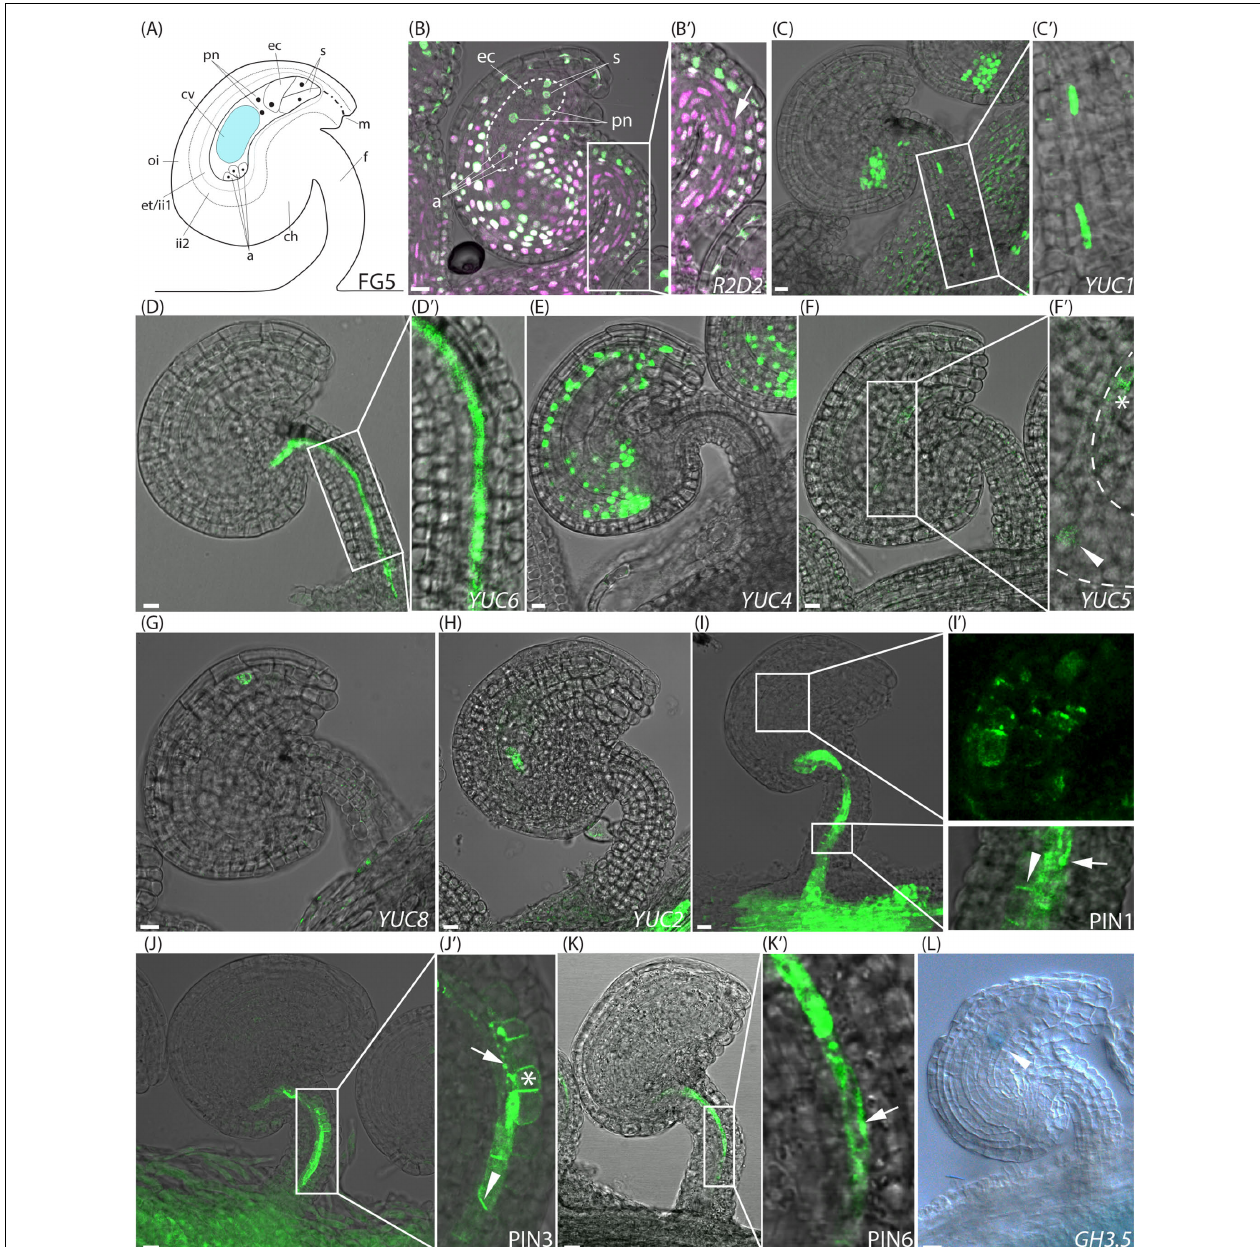
FIGURE 1 | Activity of auxin related reporters at the pre-anthesis stage of FG5. (A) Schematic overview of an ovule at stage FG5. a, antipodal cells; ch, chalazal domain; cv, central vacuole; ec, egg cell; et, endothelium; f, funiculus; ii, inner integuments; m, micropylar end; oi, outer integuments; pn, polar nuclei; s, synergid cells. (B–K) Merged confocal and transmitted light images, showing the expression of different fluorescent reporter constructs in ovules carrying an embryo sac at the seven cell, eight nuclei stage. (B (cid:48) ,C (cid:48) ,D (cid:48) ,F (cid:48) ,I (cid:48) ,J (cid:48) ,K (cid:48) ) show higher magnifications of the boxed areas in (B,C,D,F,I,J,K) , respectively. (B,B (cid:48) ) R2D2 activity, dotted area indicates the female gametophyte with annotations as in (A) , arrow indicates DII depletion in the central funicular cell files. (C) YUC1pro:n3xGFP expression in the chalazal domain of the ovule and in the third cell file of the funiculus, (D) YUC6pro:eGFP expression in the fifth cell file of the funiculus, (E) YUC4pro:3xGFP expression in the inner integuments, (F,F (cid:48) ) YUC5pro:eGFP expression in the micropylar end of the inner integuments (star) and in the female gametophyte (arrowhead), dashed line indicates female gametophyte, (G) YUC8pro:eGFP expression in the micropylar end of the inner integuments, (H) YUC2pro:eGFP expression in the female gametophyte, (I,I (cid:48) ) PIN1pro:PIN1-GFP expression around the female gametophyte and in the three most central cell files of the funiculus, arrowhead indicates basal PIN1 localization, arrow indicates internal PIN1 localization. (J,J (cid:48) ) PIN3pro:PIN3-GFP expression in the five most central cell files of the funiculus, arrowhead indicates basal PIN3 localization, arrow indicates internal PIN3 localization and star indicates apolar PIN3 localization. (K,K (cid:48) ) PIN6pro:PIN6-GFP expression in the fifth cell file of the funiculus, arrow indicates internal PIN6 localization. (L) DIC image of a GUS stained stage FG5 GH3.5pro:GUS ovule, arrowhead indicates GH3.5 expression in the female gametophyte. Bars = 10 µ m. All images are representatives of at least 10 independent